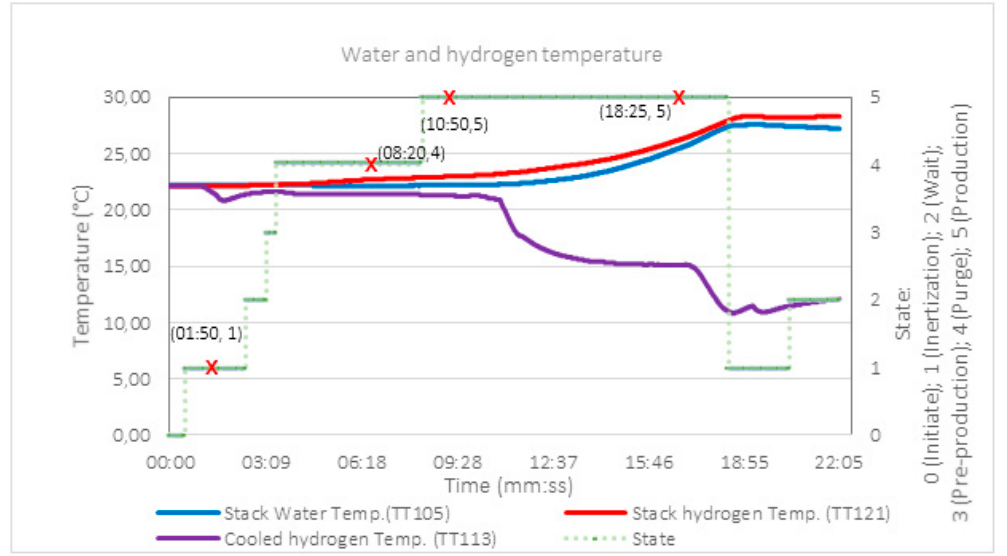
Figure 19. Experimental results. Water and hydrogen temperature evolution during a start-stop cycle.